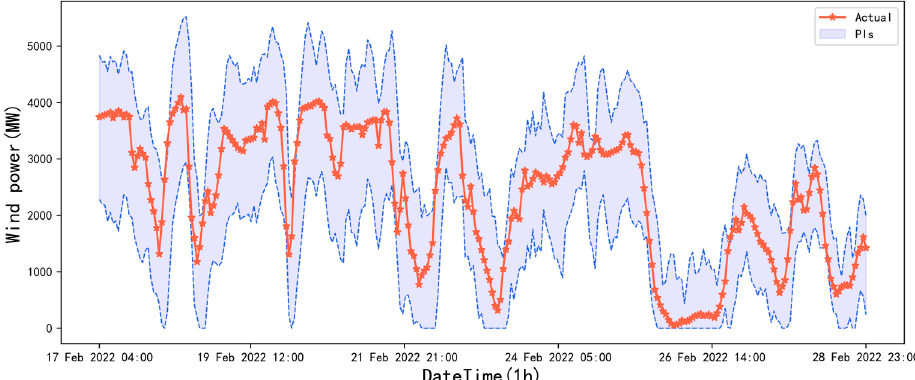
Figure 13. Plot of the prediction intervals of the QRNN-based